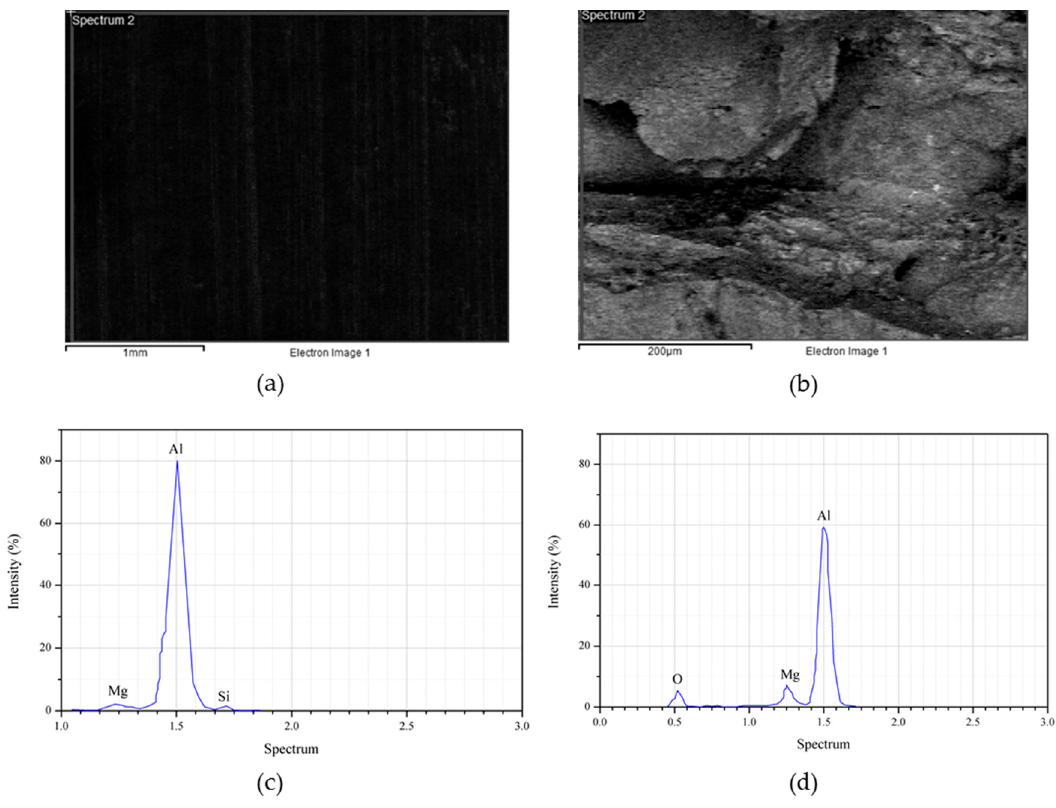
Figure 9. The scanning surface sample for ( a ) AR AA6061 and ( b ) MMC-Al R at the maximum parameters, and the EDS spectrum for ( c ) AR AA6061 and ( d ) MMC-Al R at maximum parameter.